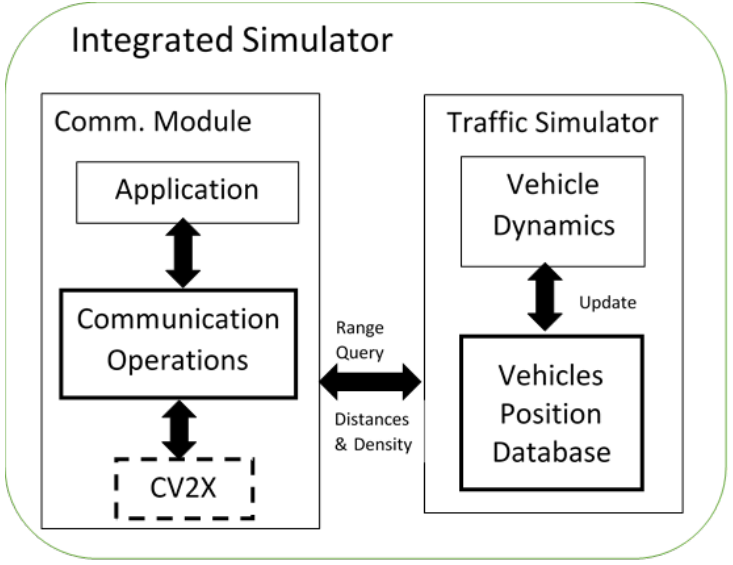
Figure 2. Integrated simulator